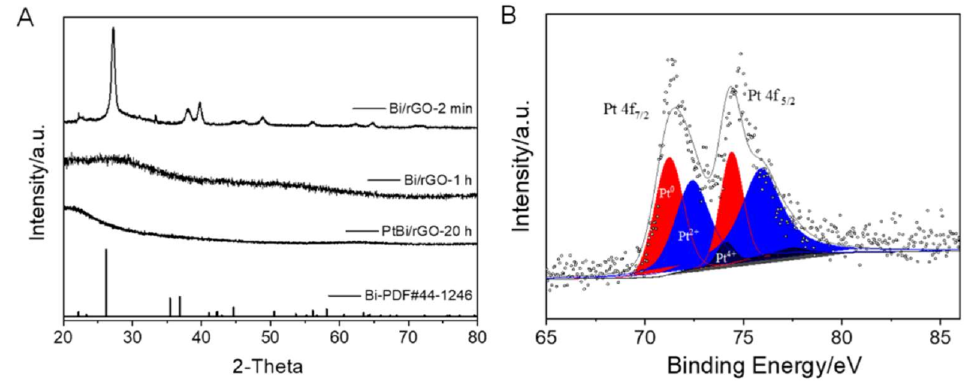
Figure 3. ( A ) XRD patterns of as-synthesized Bi/rGO-2 min, Bi/rGO-1 h, and Pt/Bi/rGO, ( B ) high-resolution XPS spectra of Pt in